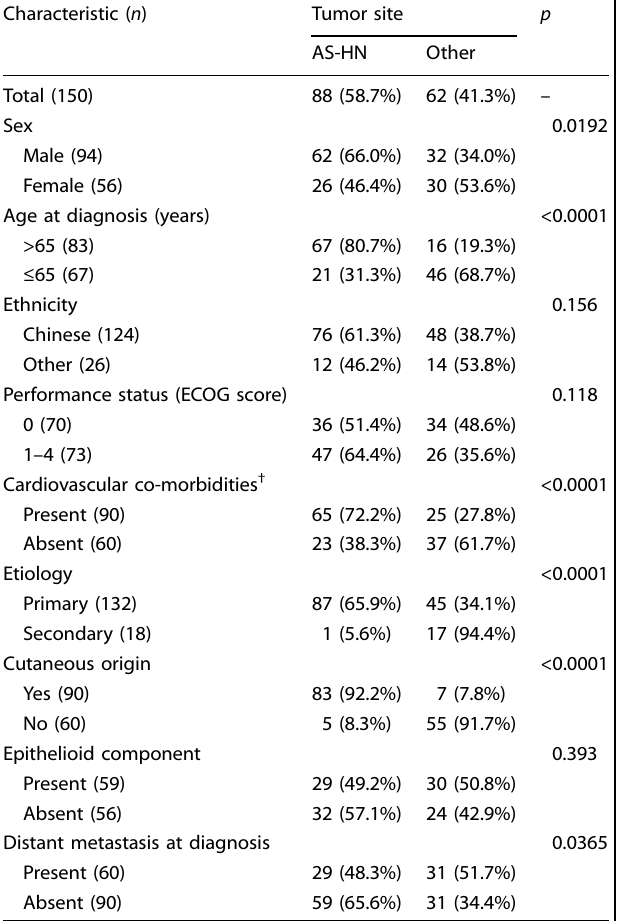
Table 2. Clinical features of head & neck angiosarcoma (AS-HN) compared to other